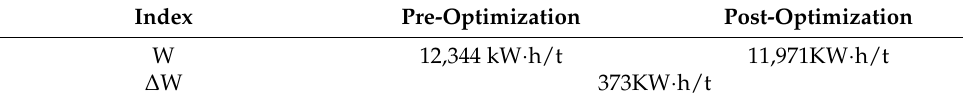
Table 7. Comparison table of DC power consumption before and after